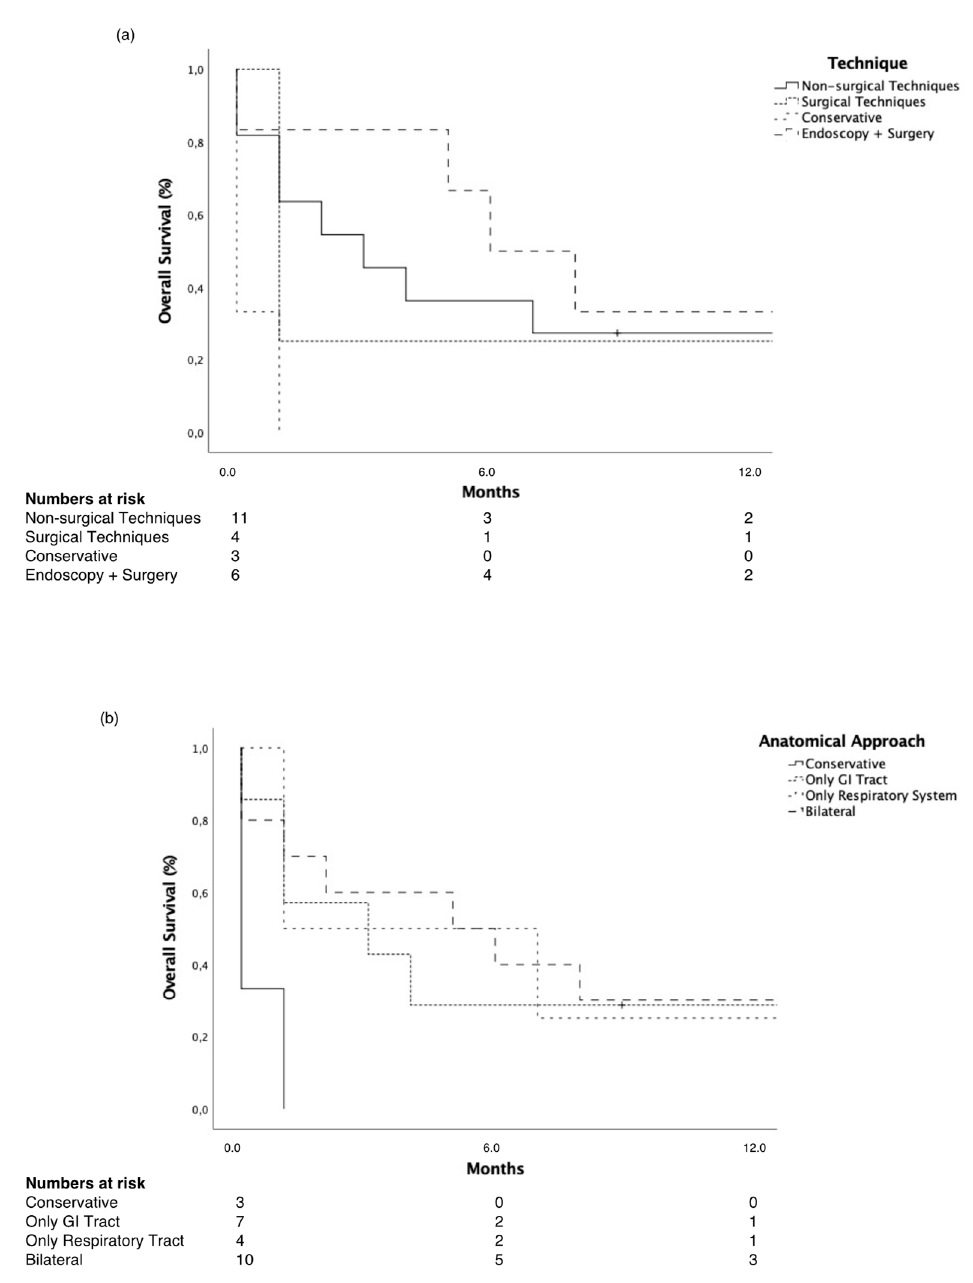
Figure 1. Overall survival by ( a ) interventional technique and ( b ) anatomical approach in T-RDF. ( a ) Non-surgical ( p = 0.04) and combined endoscopic and surgical intervention ( p = 0.04) proved significantly longer survival compared to best supportive care. ( b ) Bilateral fistula repair was associated with significantly longer survival compared to best supportive care ( p = 0.02). GI—gastrointestinal; T-RDF—tumor-associated respiratory–digestive tract fistula.